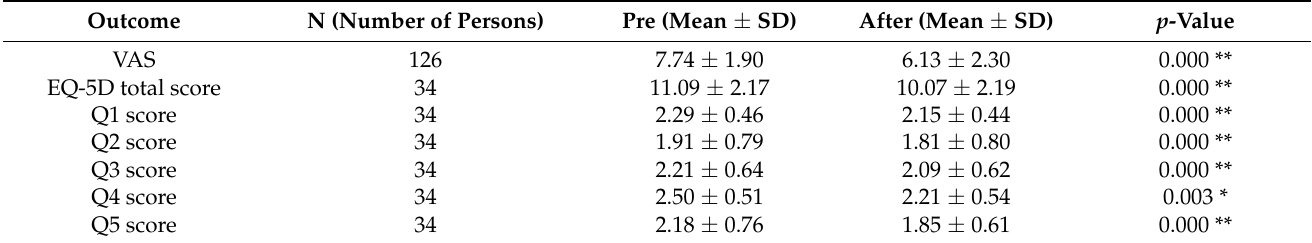
Table 3. Effectiveness of TKM Services.